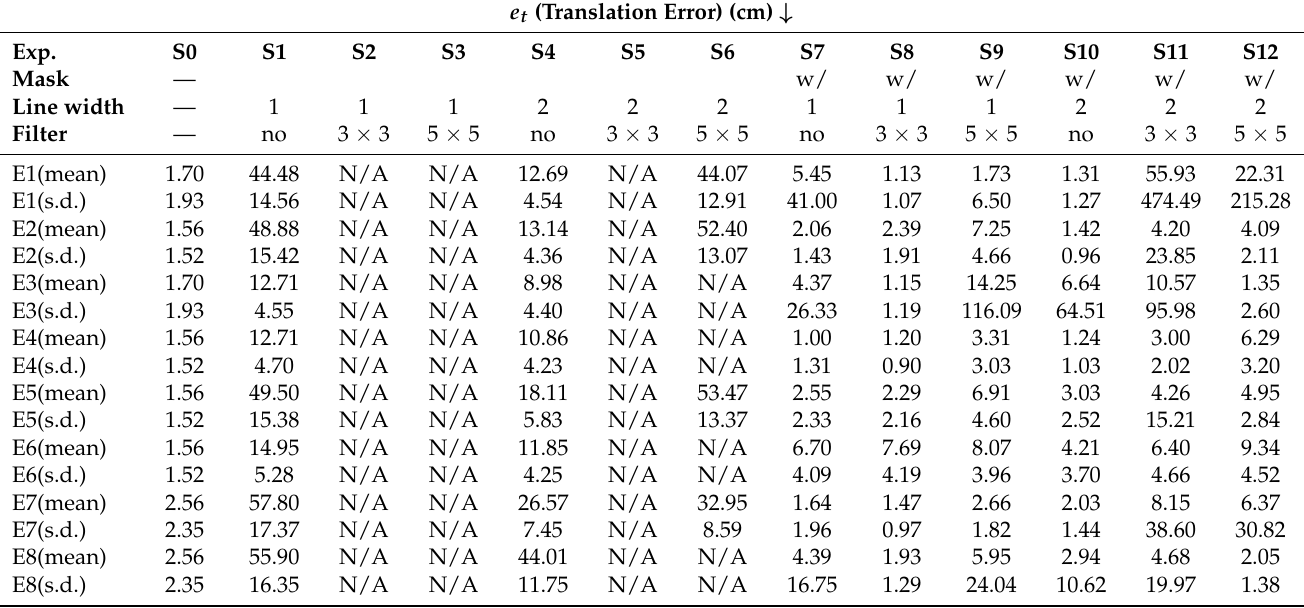
Table 2. Translation error. S0 is the previous method. S1~S12 are the proposed methods. ’s.d.’ means standard deviation. N/A means the training is not converged. ↓ means lower value is more accurate.